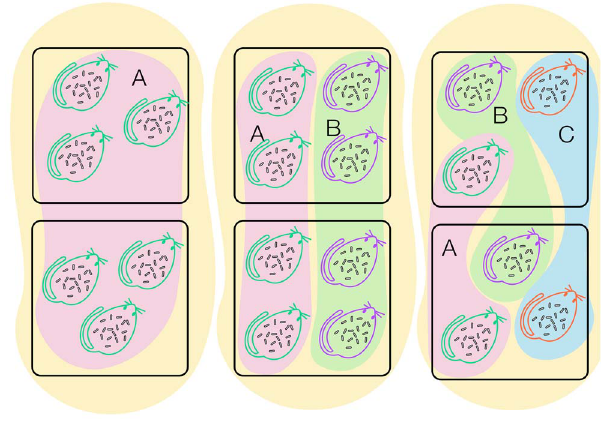
Figure 1. A schematic illustration of the experimental design. Rodents were trapped in 1-ha plots (squares), representing populations of Gerbillus andersoni [(A), host individuals are represented as green rodent outlines and the populations are shaded pink], G. pyramidum [(B), purple outlines and green shading] and G. gerbillus [(C), red outlines and blue shading]. The rodent populations were part of three communities; a single host species ( G. andersoni , left tan shading), two ( G. andersoni and G. pyramidum , middle tan shading) or three rodent species communities (right tan shading). Bacterial lineage (rod-like shapes) diversity and composition were assessed for three organization levels (individuals, populations and communities of hosts) nested within three hierarchical spatial scales (a host individual, a plot, and a region).